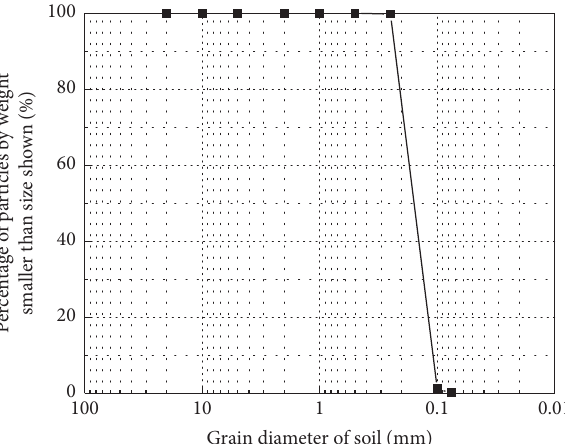
Figure 3: Grading curve of aeolian sand particles.